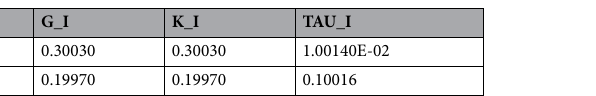
Table 2. Prony Series Fit